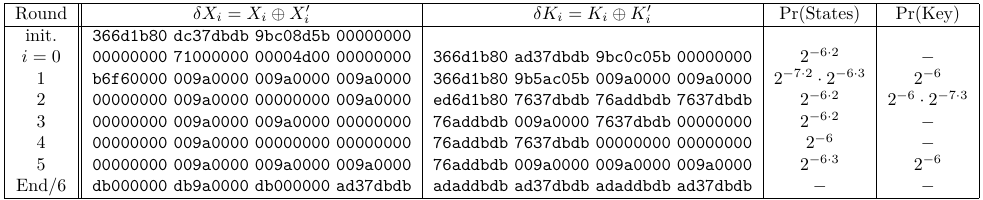
Table 1: The optimal 6-round related-key differential characteristic for AES-128. It has 21 active S-boxes, and occurs with probability 2 − 131 . The four words represent the four columns and are given in hexadecimal notation. We have the relation: δX ⊕ δK 0 = δX 0 . Round δX i = X i ⊕ X 0 i δK i = K i ⊕ K 0 i Pr(States) Pr(Key) init. 366d1b80 dc37dbdb 9bc08d5b 00000000 i =